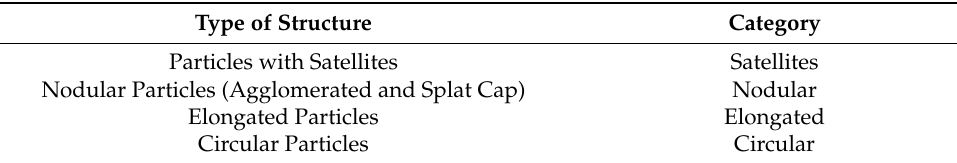
Table 2. The table contains information about the categorization of the structures founds within the images.